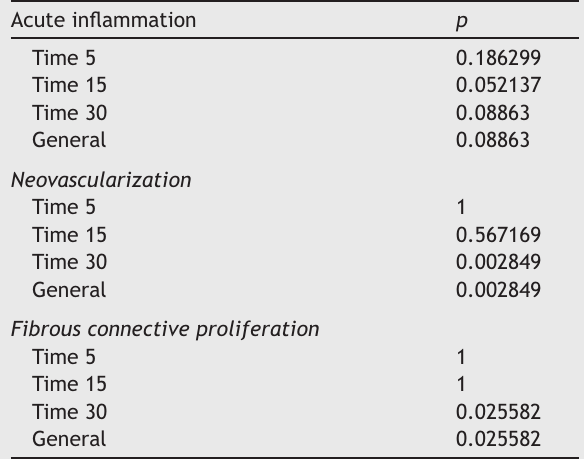
Figure 4 Mucosa of the maxillary sinus showing normal epithelium, without inflammatory process. Optical microscopy, HE staining, 100 × . Table 2 Results of data comparisons between parameters---acute inflammation, neovascularization and fibrous connective proliferation for different treatment follow